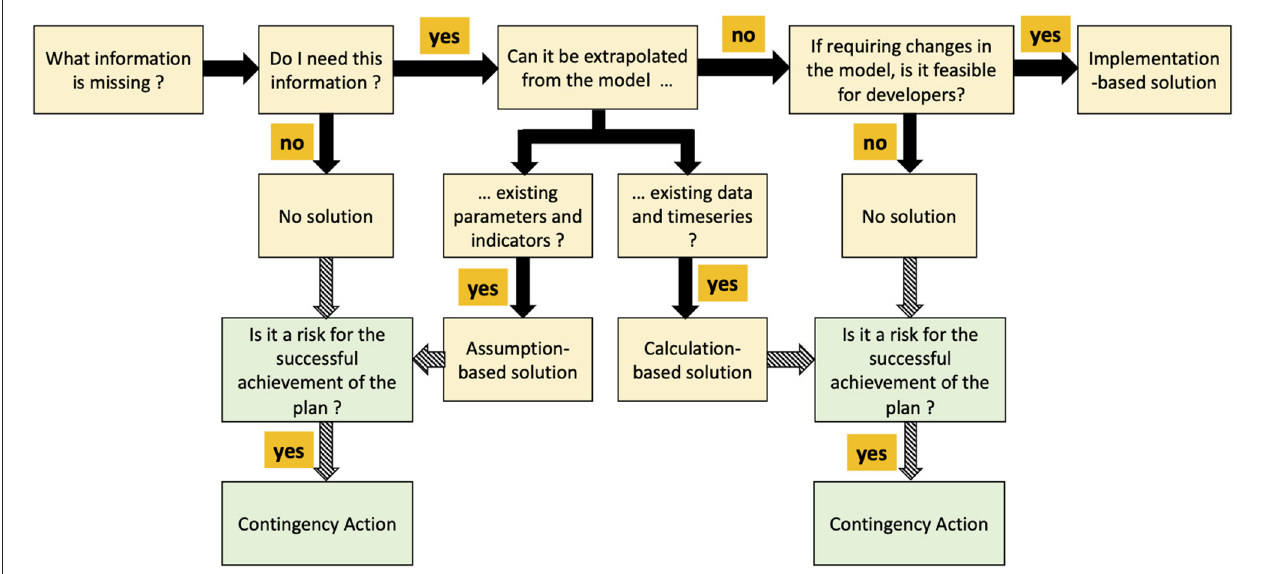
FIGURE 4 | Heuristic approach to identifying minimum information requirements. Two types of solutions are considered, for the model (yellow) and for the plan (green). Black arrows are considered as solution identification paths to integrate in the model. Dashed arrows are indicative of solution pathways requiring additional attention when designing the adaptive plan, based on the consideration of extra-measures in situations where relevant information is partially, indirectly, or not represented at